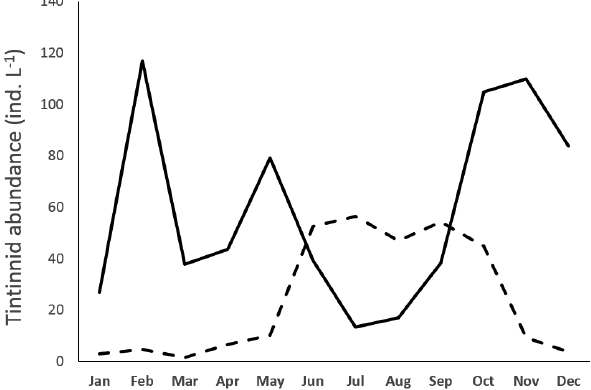
Figure 4. Monthly averaged abundance (ind. L -1 ) of agglutinated (black) and hyaline (dashed) tintinnids integrated within the 0–15 m water column from July 1998 to July 2016.